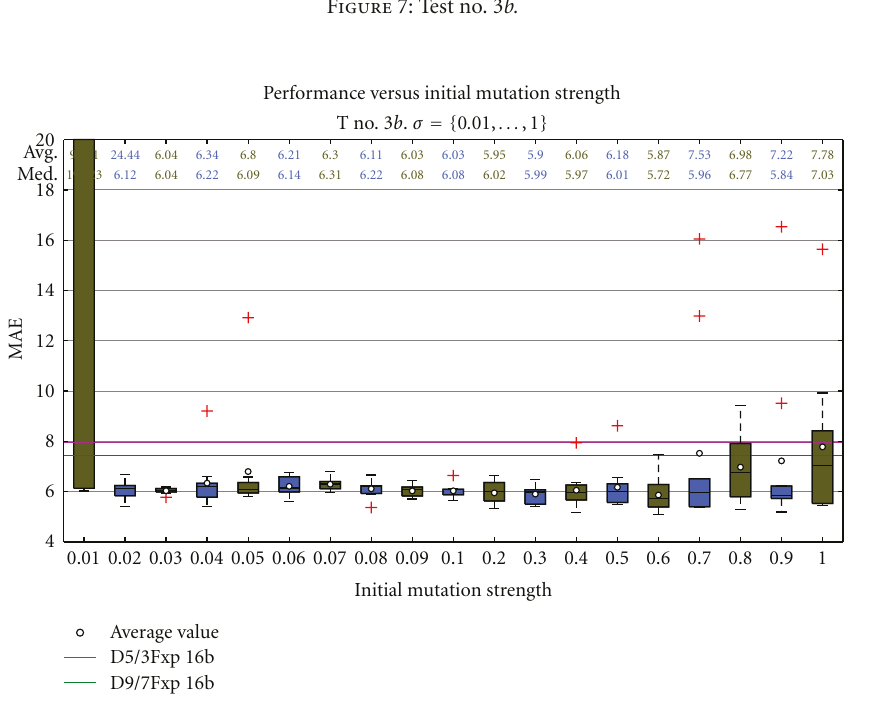
Figure 8: Test no. 3